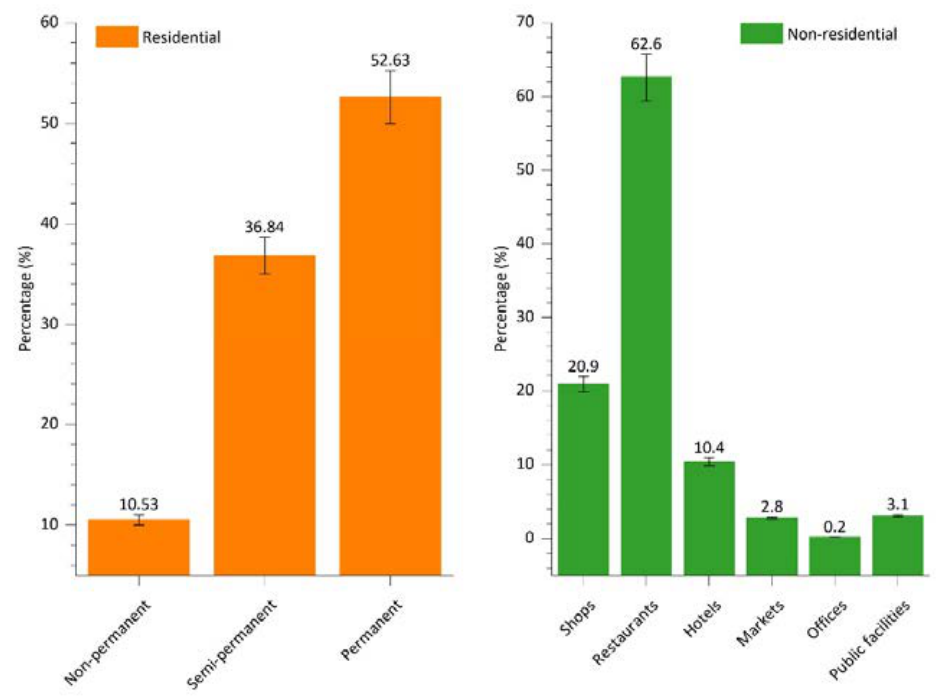
Fig. 3: Waste generation based on samples group